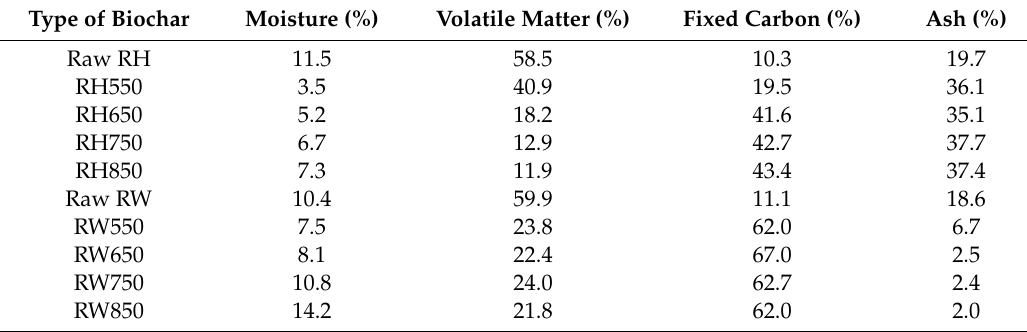
Table 2. Proximate analysis of raw biomass and